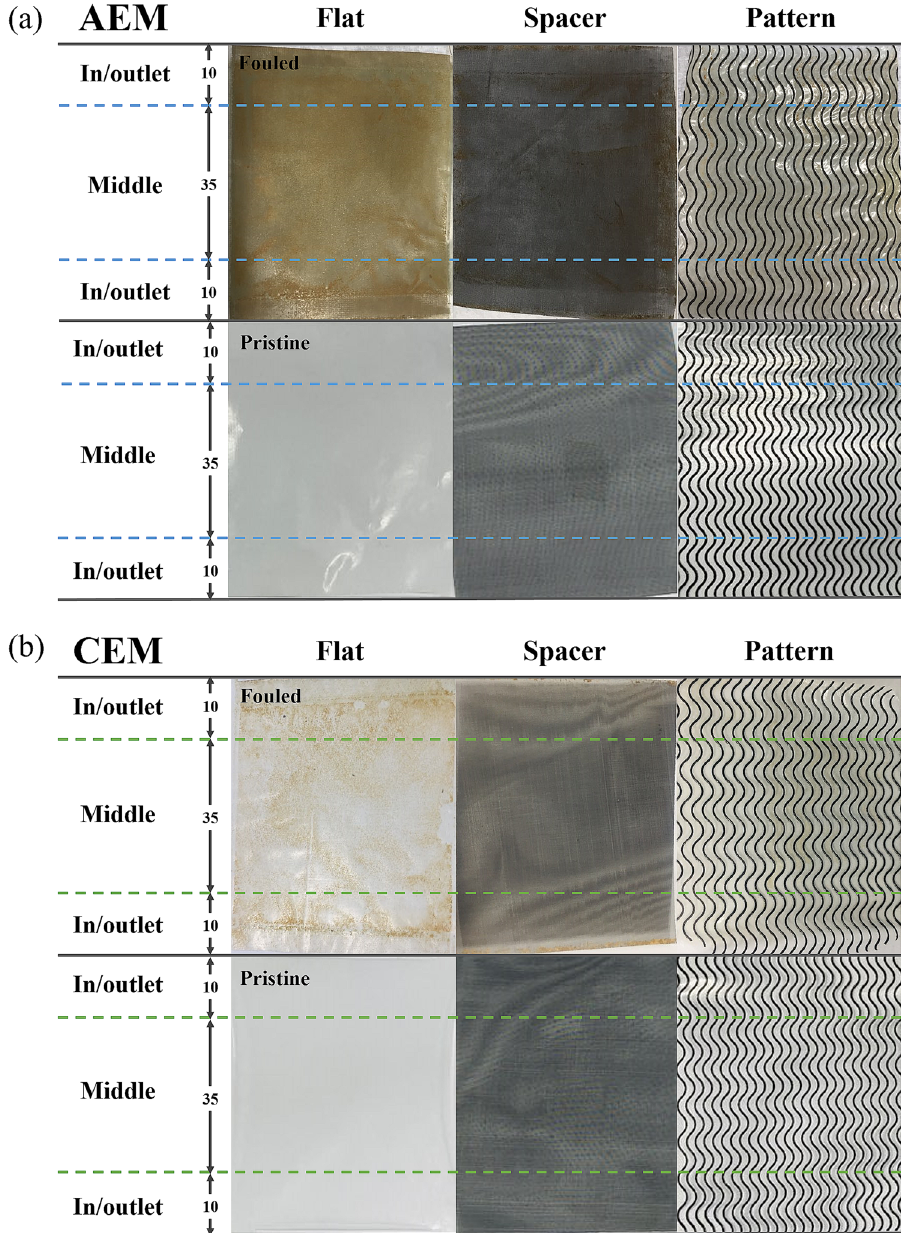
Fig. 4 Photographs of fl at, spacer, and patterned membranes before and after continuous RED operation for 5 days. a Shows photographs of AEMs at the sewage ef fl uent side. b Shows photographs of CEMs at the underground seawater side. The dimensions of the divided regions in this fi gure are in millimeters. The samples before and after continuous RED operation were classi fi ed into fouled or